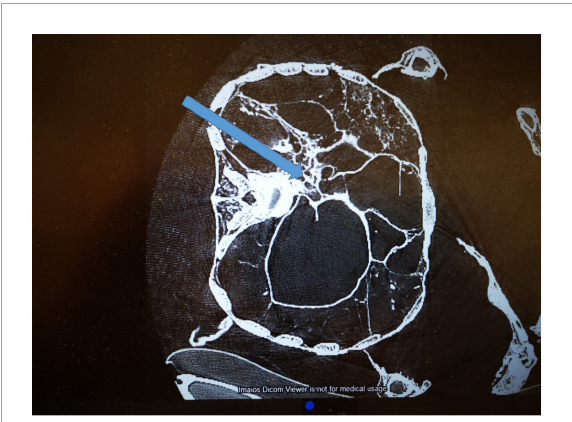
FIGURE6 CT cross-section of the thorax at the level of the dorsal defect. The arrow indicates the presumed direction of an obvious stabbing wound reaching to the aorta and being surrounded by some major radiodense